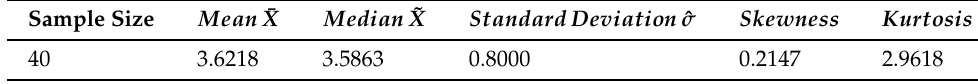
Table 6. Theoretical statistical measures from SBXL for